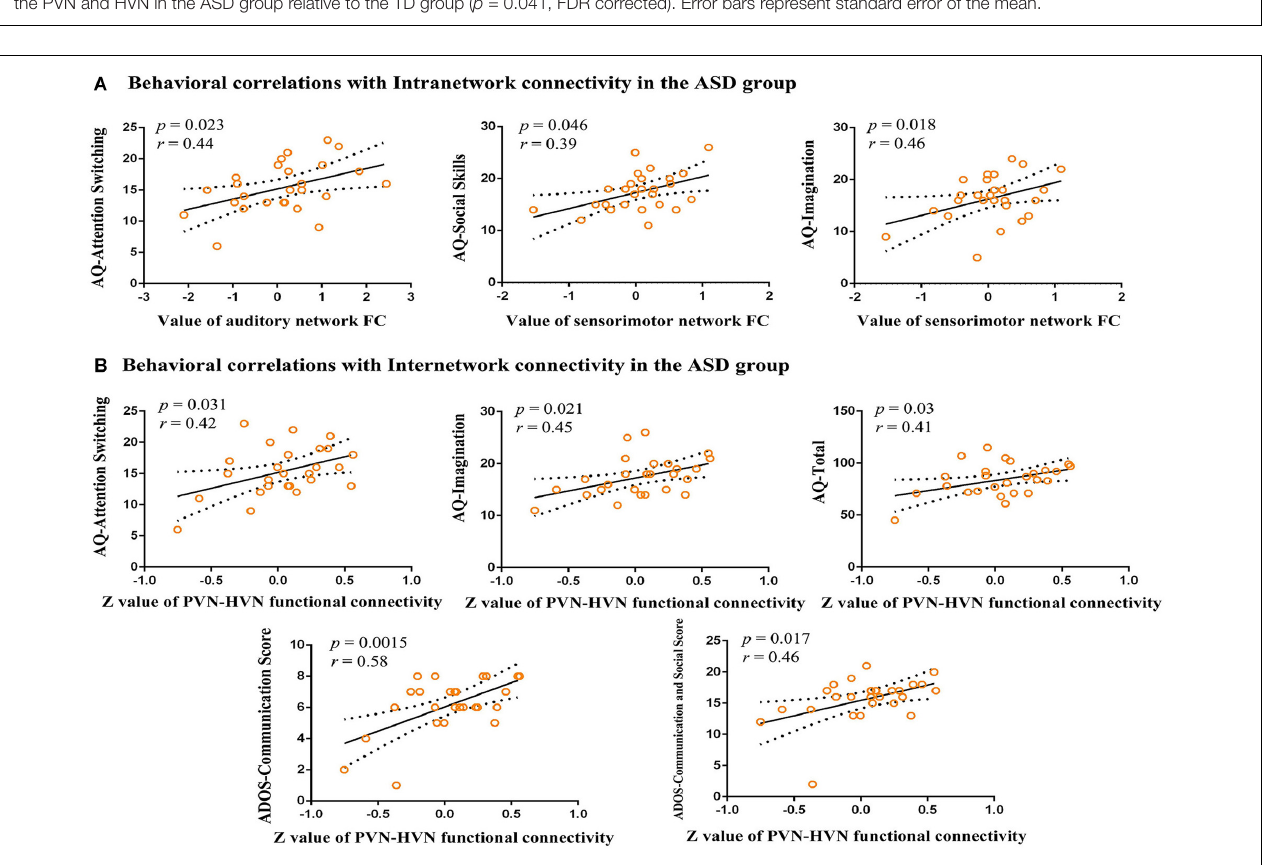
FIGURE 3 | Connectivity strength ( z- value) between two networks in two participant groups. **Represent significant differences after FDR correction. (A) Increased positive FC was found between the AN and SMN in the ASD group relative to the TD group ( p = 0.022, uncorrected). (B) Increased positive FC was found between the PVN and HVN in the ASD group relative to the TD group ( p = 0.041, FDR corrected). Error bars represent standard error of the mean.